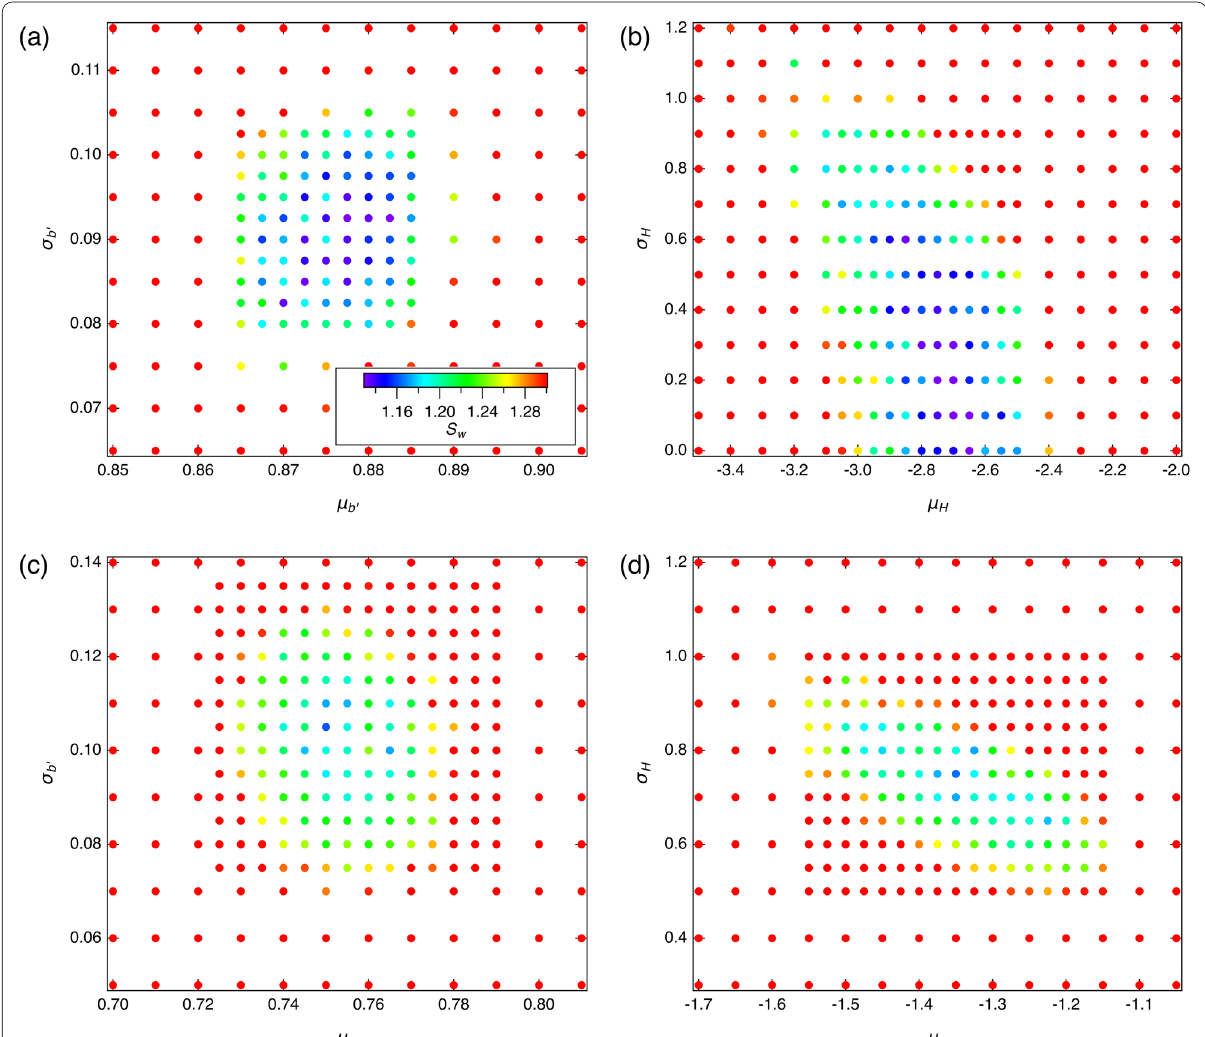
Fig. 18 Grid search results for parameters related to the distribution of parameters in the L-L formula (Eq. 7) representing the FMD. The “colder” the 0.2 are fixed. b Grid search results of µ H and σ H in area A; 2.7 and σ H color, the better the fit. a Grid search results of µ b , and σ b in area A; µ H ′ ′ = = − 0.75 are fixed. d Grid search results for µ H 0.875 and σ b 0.09 are fixed. c Grid search results of µ b 1.3 and σ H µ b and σ b in area B; µ H ′ = ′ = ′ ′ = = − 0.75 and σ b 0.105 are and σ H in area B; µ b ′ = ′ =